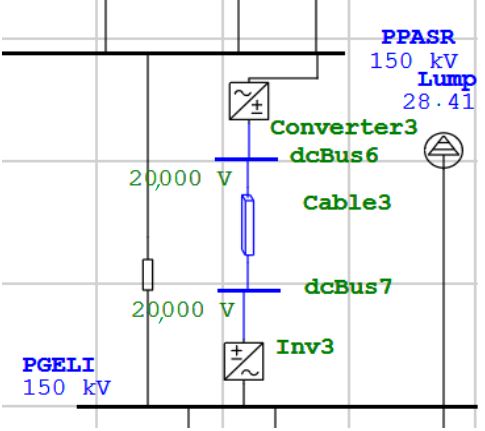
Figure 4. Placement of the HVDC Transmission System at Paya Pasir (Bus 5)–Paya Geli (Bus 7). The calculation of the rectifier-inverter transformer rating on the 150 kV Paya Pasir (Bus 5)–Sei Rotan (Bus 11) line was performed as follows: S transformer rectifier = √2 × In × V sec R ec